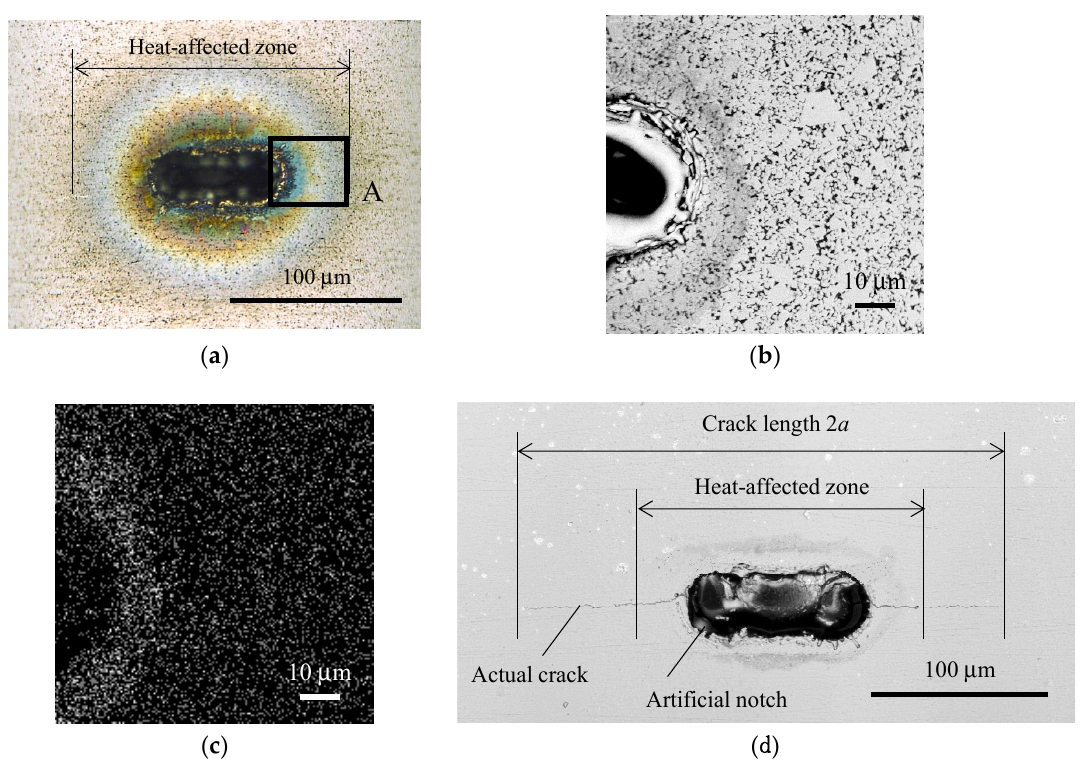
Figure 5. Example of an artificial notch ( a – c ) and a short surface fatigue crack initiated from the notch ( d ): ( a ) Optical microscope image of laser beam machined notch; ( b ) SEM image of A around the notch in Figure 5a; ( c ) The oxygen signal mapping in the exact area of Figure 5b evaluated by energy dispersive X-ray spectrometry (EDS); ( d ) Appearance of a short surface fatigue crack on a replica film.